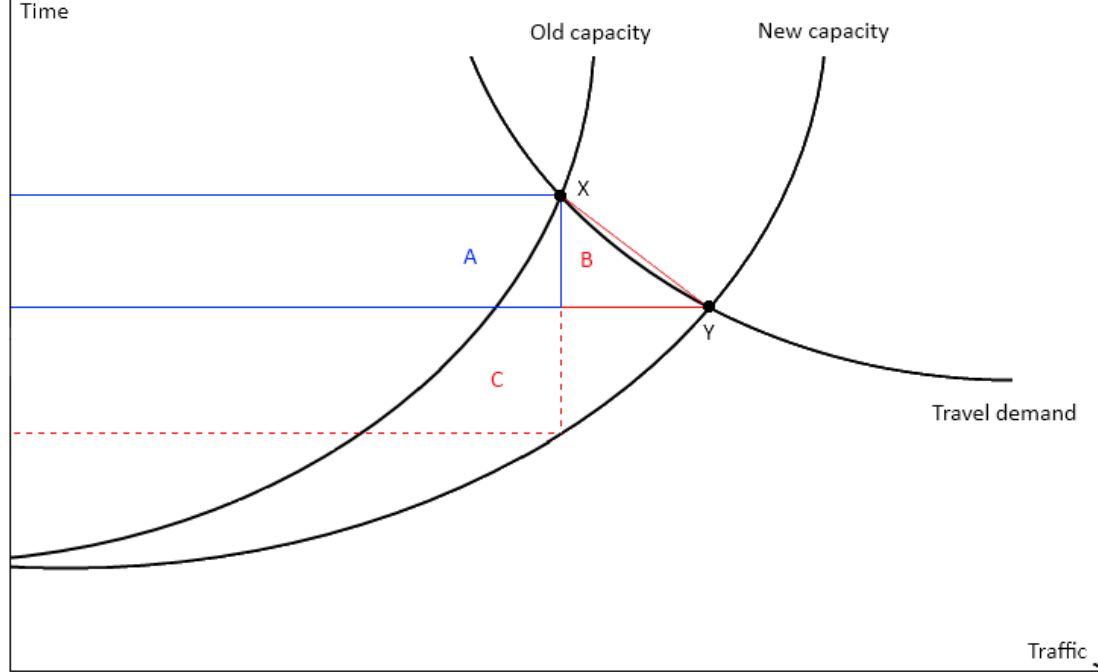
Figure 3. Example of supply and demand curves and time-benefit calculations for a road before and after capacity increase. Adapted from Nielsen and Fosgerau (2005), p.